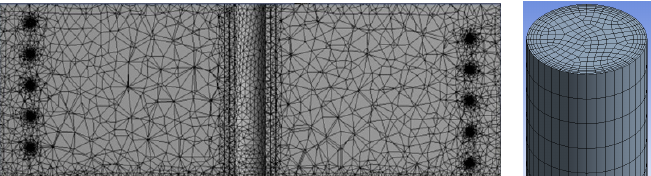
Figure 3. Cross section of the optimum grid for the analysis consisted of 8,107,644 cells and 4,092,668 nodes [15].